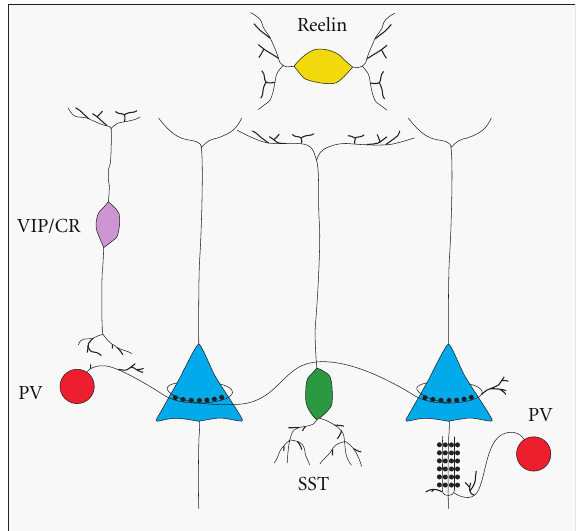
Figure 1: Interneuron diversity. Interneurons are diverse in terms of their histochemical profile, morphology, physiological properties, and connectivity. In this schematic representation, parvalbumin-positive (PV) interneurons (red) include basket cells forming perisomatic contacts on adjacent pyramidal cells (dark blue), as well as chandelier cells that target the pyramidal cell axon initial segment. Somatostatin- positive (SST) interneurons include Martinotti cells that contact pyramidal cell dendrites in layer I. Vasointestinal peptide (VIP) and calretinin (CR) double-positive bitufted interneurons target pyramidal cells and other interneurons. Neurogliaform cells, marked with reelin, are the most abundant interneurons in layer I and provide tonic GABAergic inhibition via volume transmission of